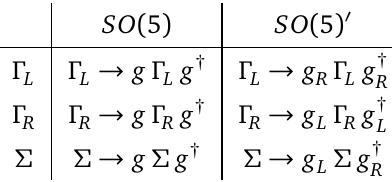
defined in (5) and the linear L , R